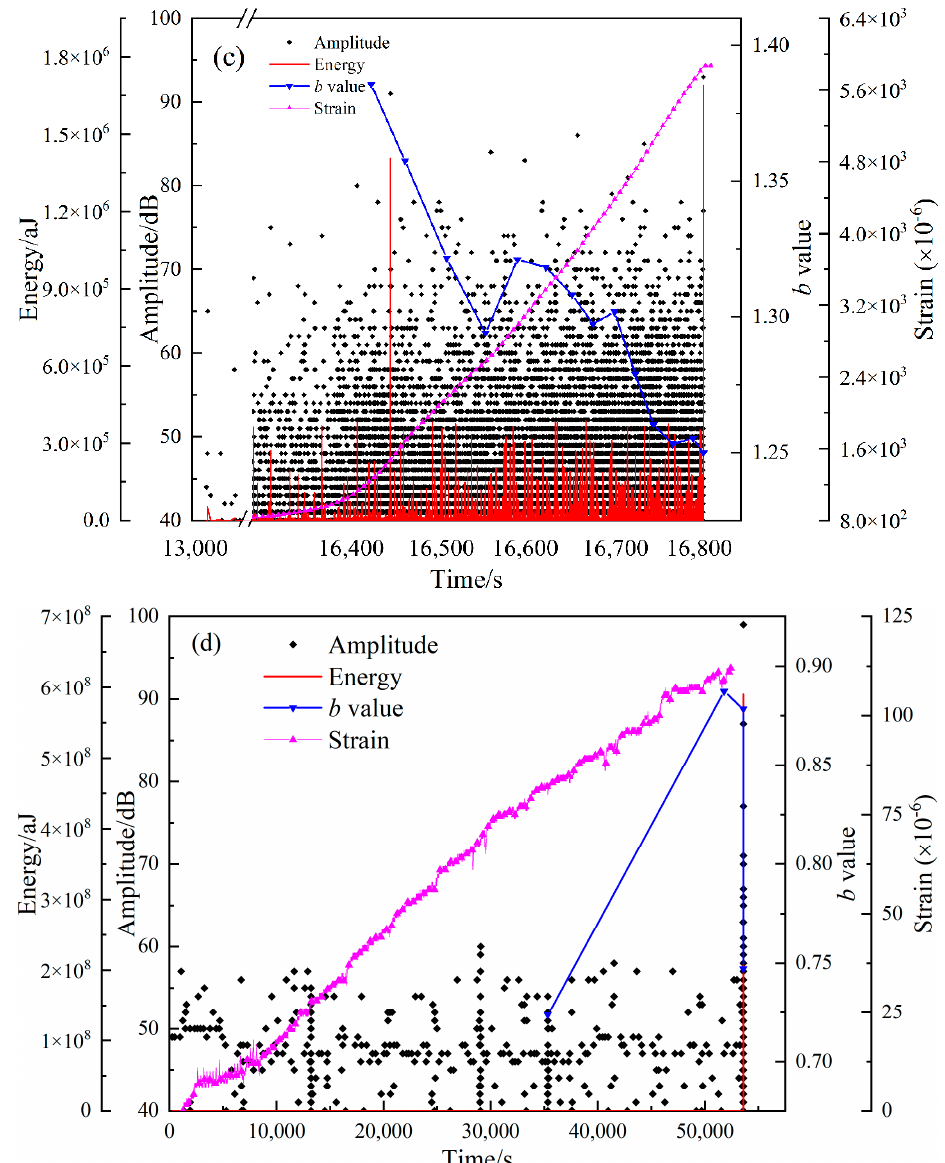
Figure 9. Temporal variation of AE b value, energy, amplitude, and strain of ( a ) red sandstone, ( b ) marble, ( c ) granite, and ( d ) limestone. Since the development of non-explosive expansion agent was very slow and few signals were generated in the early stage of the tests, the starting time of the experimental analysis selected here was different.